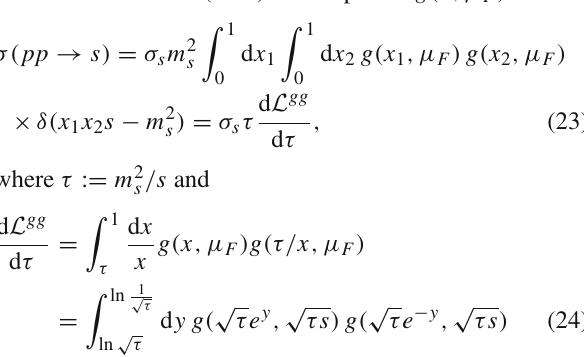
Fig. 3 Production cross section σ( pp → s ) for = 2 (cid:5) b (top/bottom partner). The result for other parameter can be g 3 obtained just by a simple scaling σ( pp → s ) ∝ with Eq. (19) and Table 1. The K -factor is not included in this